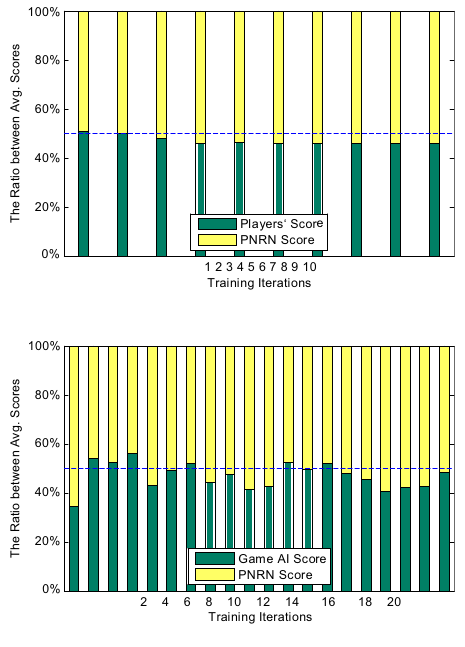
Figure 8. Comparison with game AI in Game Level 6